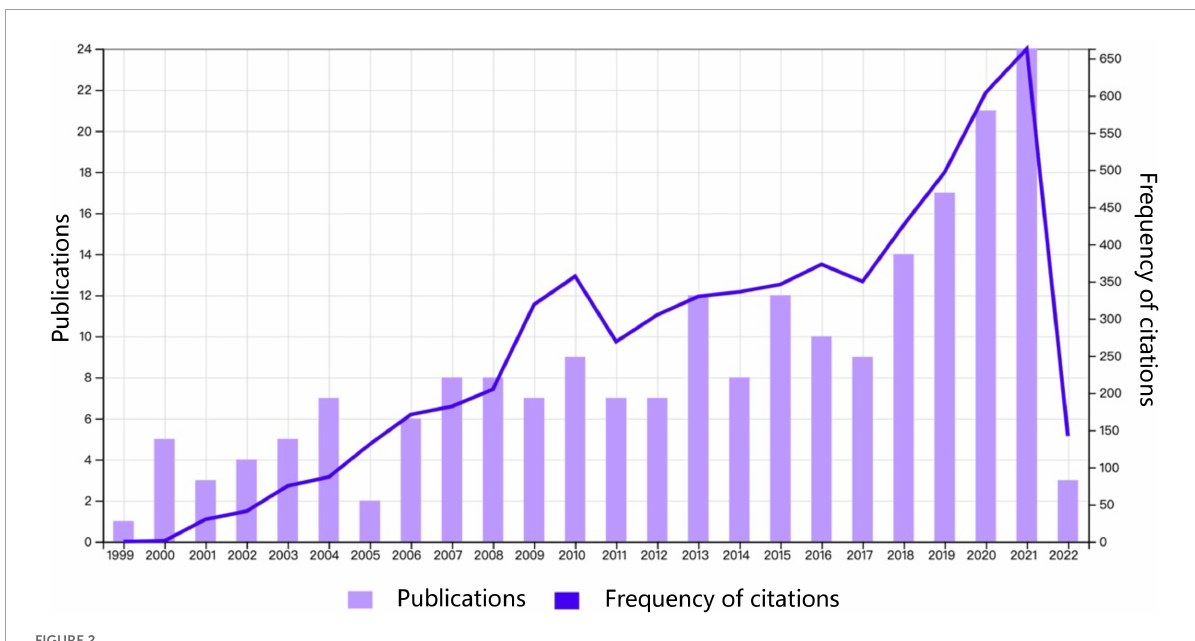
FIGURE2 Trends of perimenopausal depression publications from 1999 to